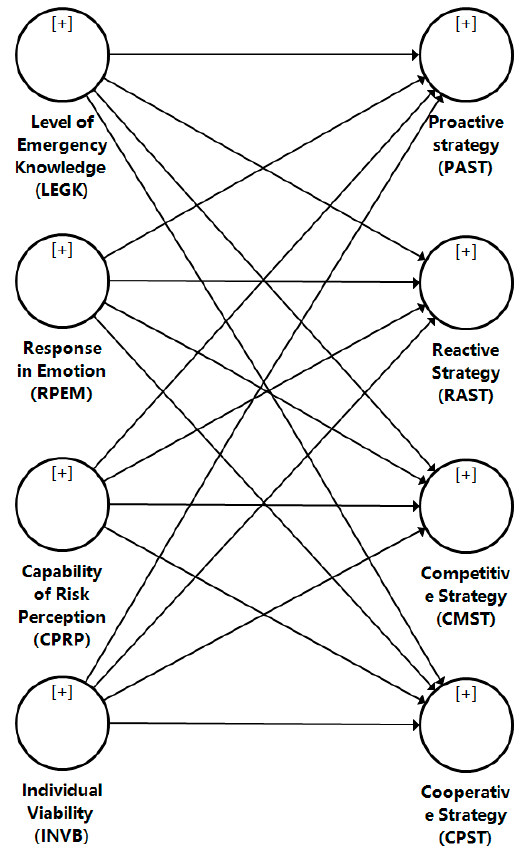
Figure 2. Hypothetical structural model.